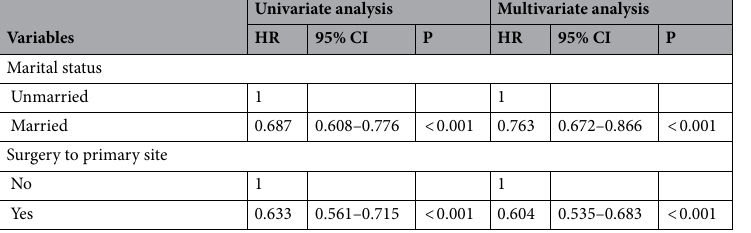
Table 3. Cox proportional hazards regression model analysis of OS in the PSM population. *1: American Indian/AK Native, Asian/Pacific Islander; 2: central portion of breast or nipple; 3: Breast, NOS.